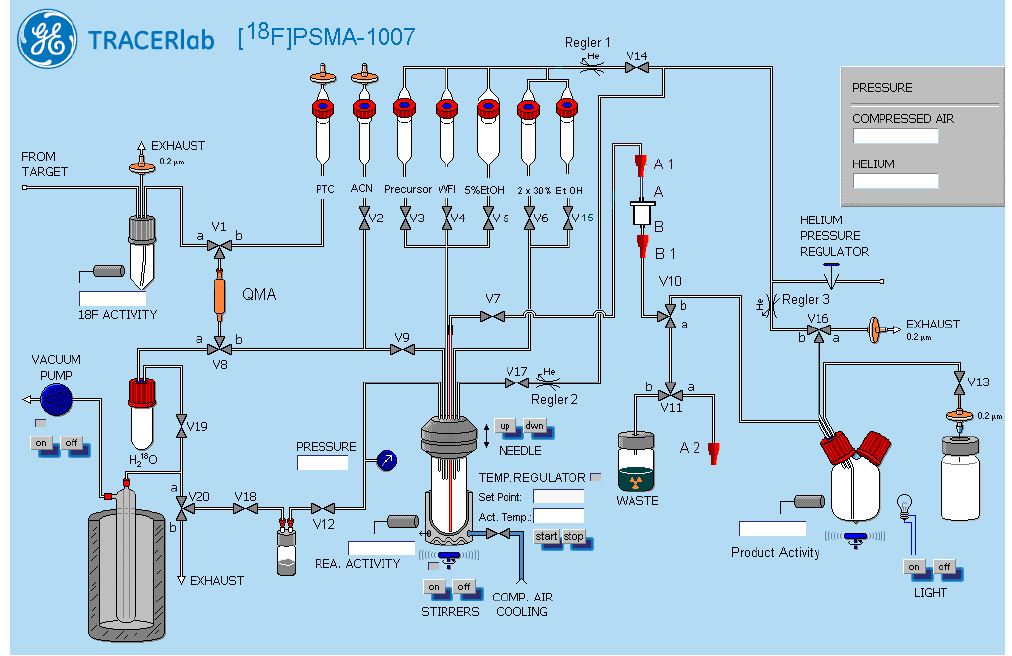
Figure 7. General setup of the radiosynthesiser for the one-step production of [ 18 F]PSMA-1007 with SPE cartridge purification on the Nuclear Interface Tracerlab FX FN system.